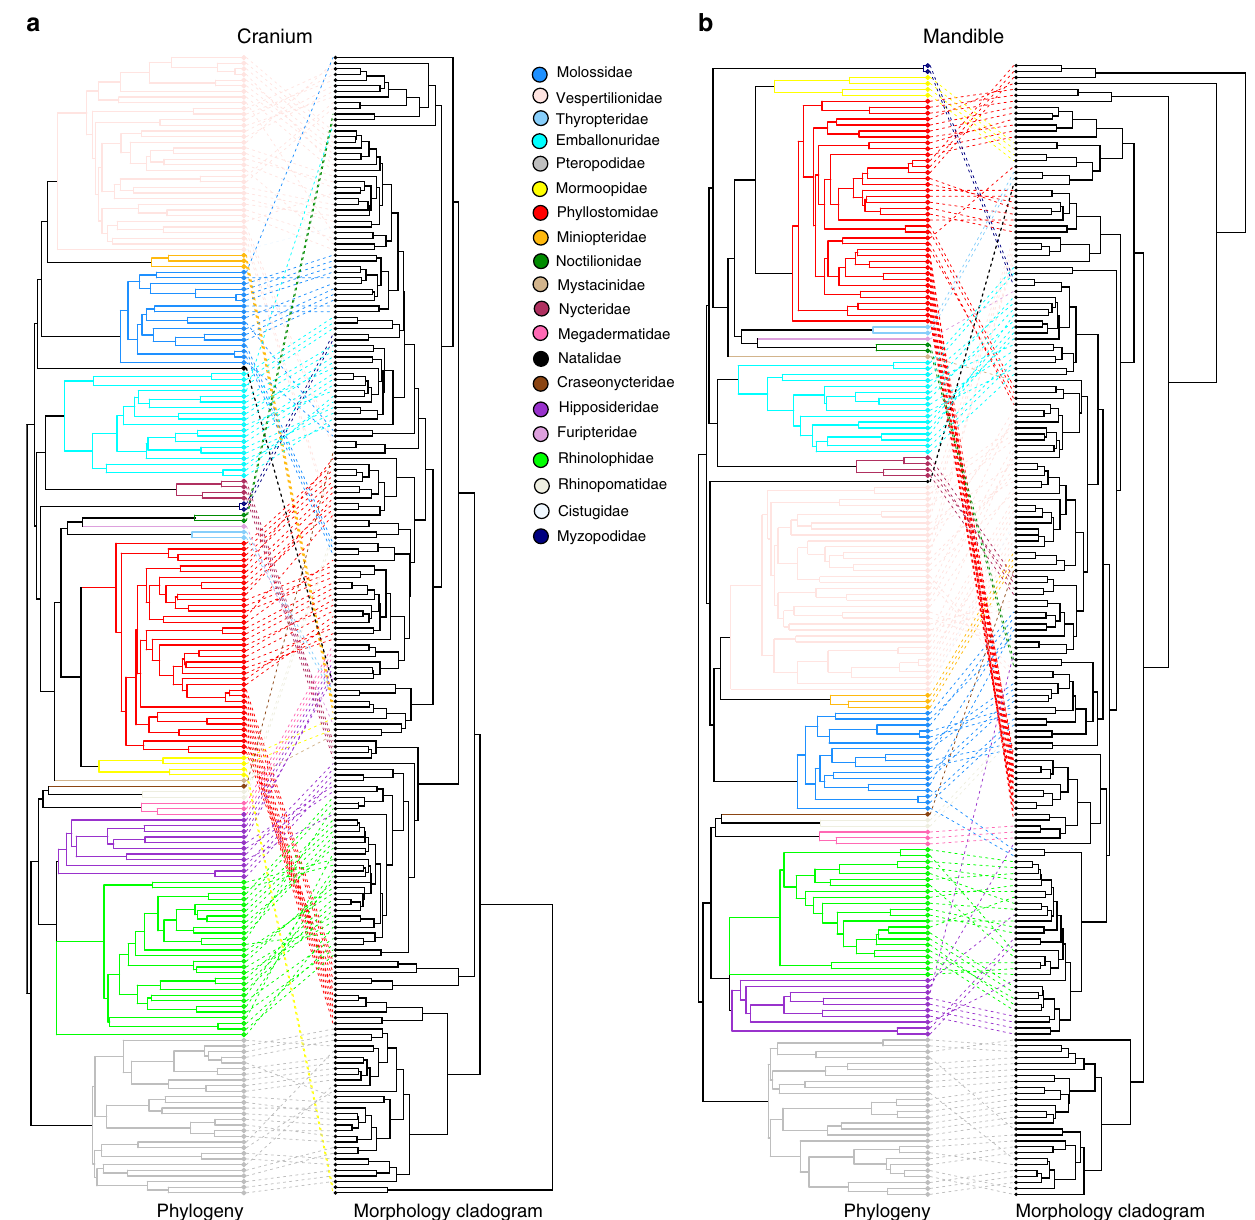
Fig. 3 Tanglegrams of phylogenetic relationships of Chiroptera, and morphology dendrograms of bat skull shape. a cranium, b mandible. Dotted lines link the same species in both